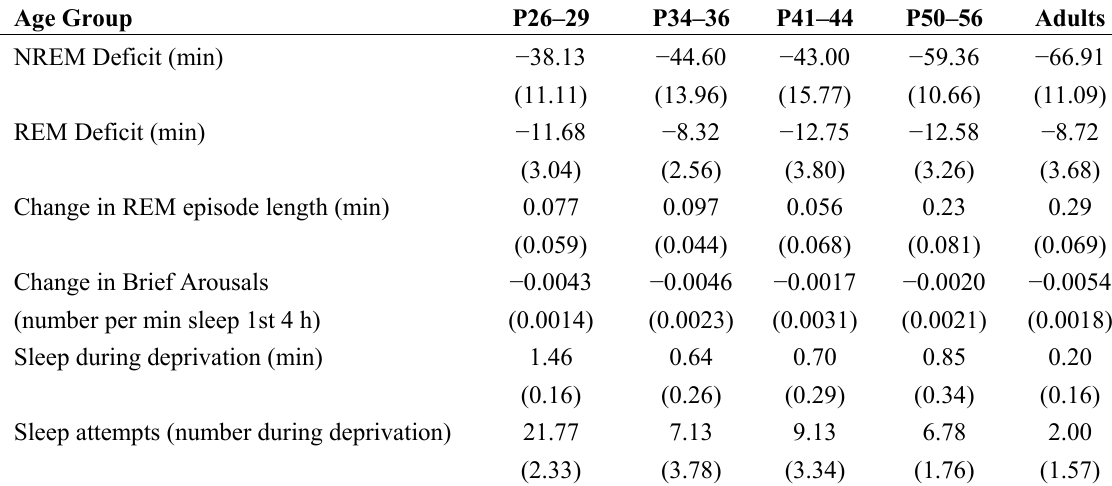
Table 1. Changes in sleep parameters following 4 h of sleep deprivation (8 a.m.–12 p.m.). Mean values and standard error (in parenthesis) for each age group are displayed. The deficit in NREM or REM sleep is the difference in minutes between the amount of each sleep phase during the recovery phase (the 20 h of recovery that follow 4 h of sleep deprivation), minus the amount during the 24 h baseline. During the first 20 h following sleep deprivation mice never recovered all the sleep that they lost during sleep deprivation, resulting in a negative value (deficit). The change in REM episode length is the difference in REM episode length for each mouse, as above calculated by subtracting the 20 h mean value during recovery minus the 24 h amount during baseline. The change in brief arousals is the difference in the number of short wake periods (<16 s) per minute of sleep during the